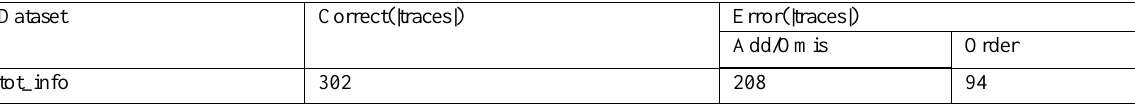
Table 8. Experiments 2: detailed information about tot_info dataset